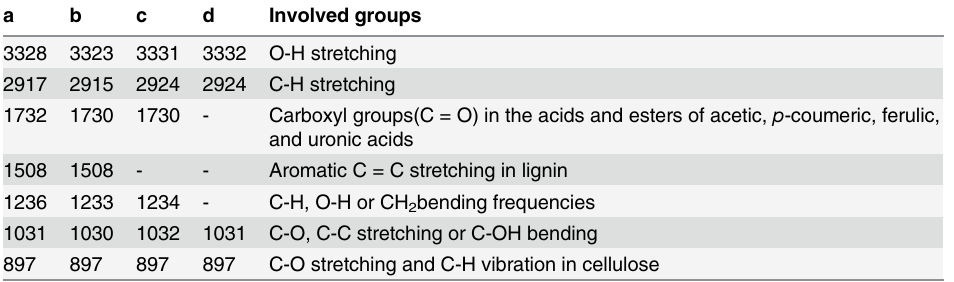
Table 2. Main absorption peaks of the samples at different treating